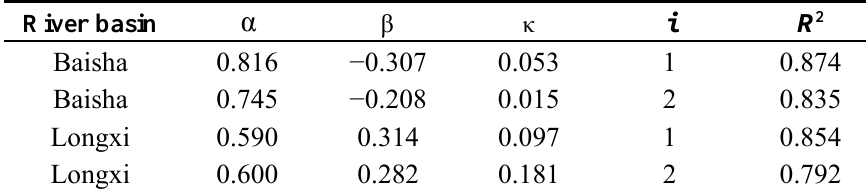
Table 1. Parameters of Equation (1) n the river